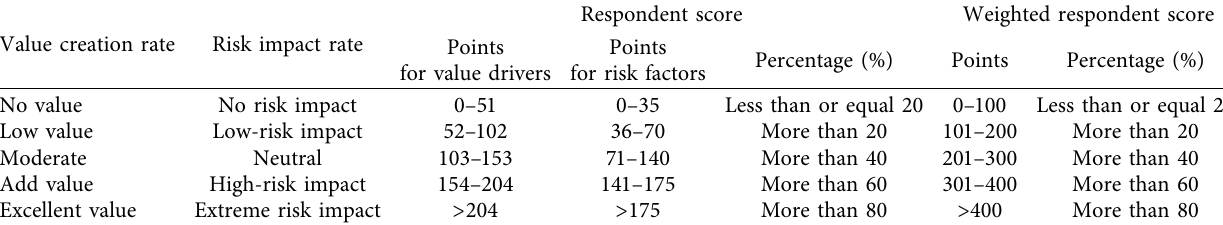
Table 1: Value creation and risk impact rating